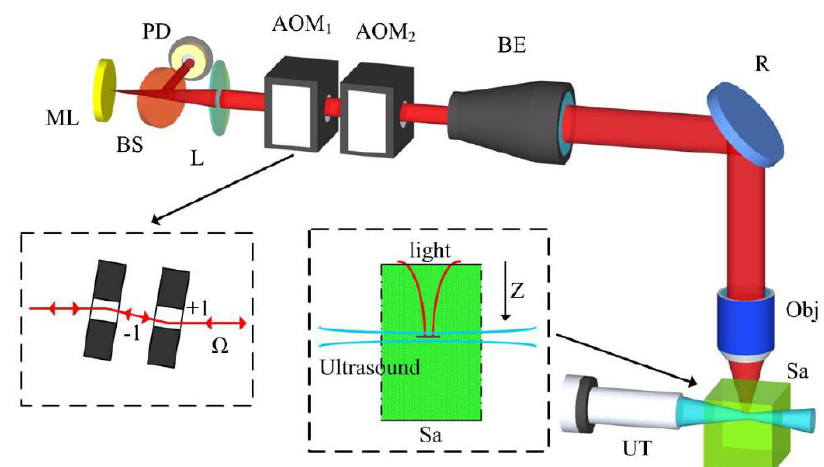
Figure 26. Schematic diagram of the ultrasound tagged laser confocal feedback imaging system. ML, microchip Nd: YVO 4 laser; BS, beam splitter; PD, photodiode; L, lens; AOM 1 , AOM 2 , acousto-optic modulators; BE, beam expender; R, reflector; Obj, objective; Sa, sample (phantom); UT, ultrasound transducer; Z, the axis of the incident light. (Figure reproduced from Ref. [97]).